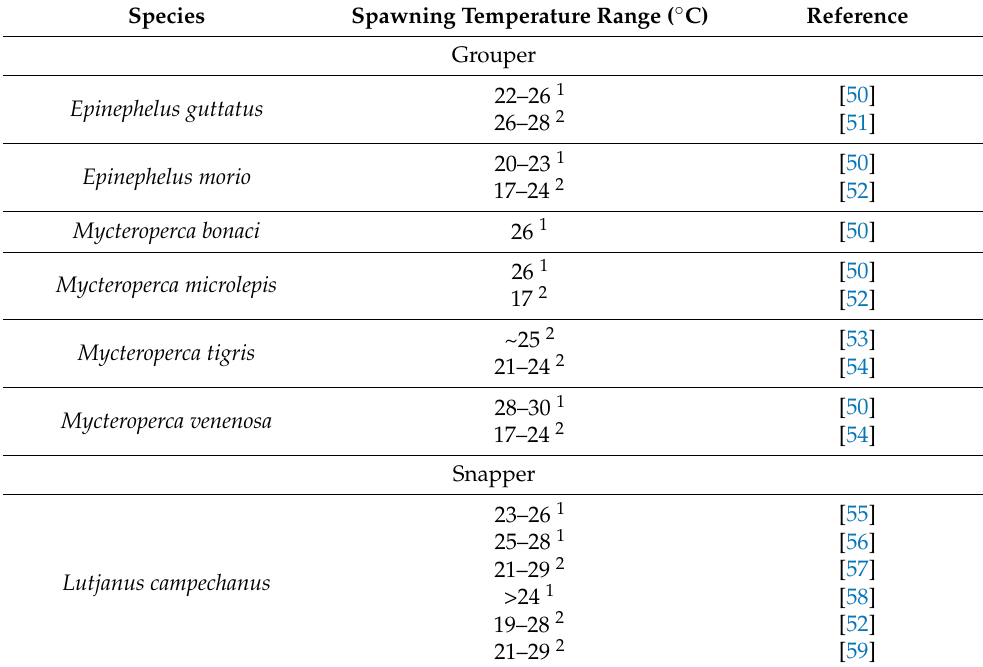
Table 2. Spawning temperature ranges observed in captivity ( 1 ) and in their natural habitat ( 2 ; bottom temperature) for grouper, snapper, and wrasse species analyzed in the present study.